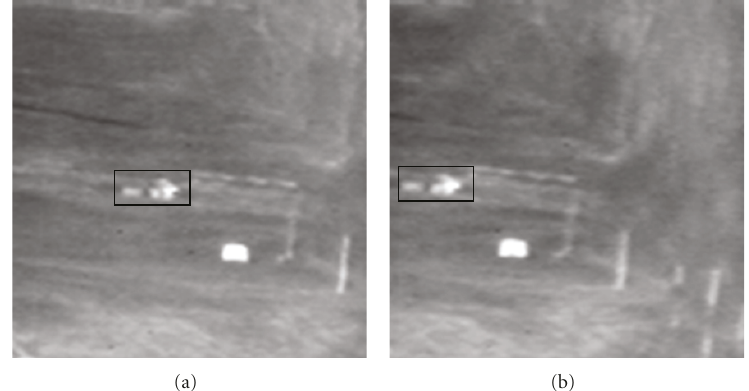
Figure 1: Two consecutive frames of an FLIR sequence acquired by an airborne camera.